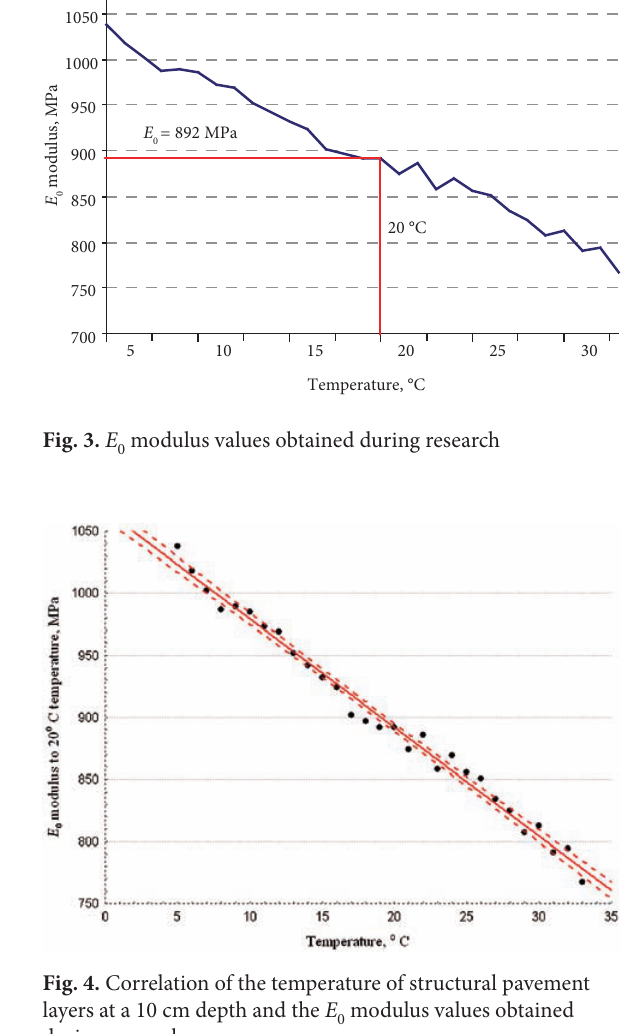
modulus values obtained 0